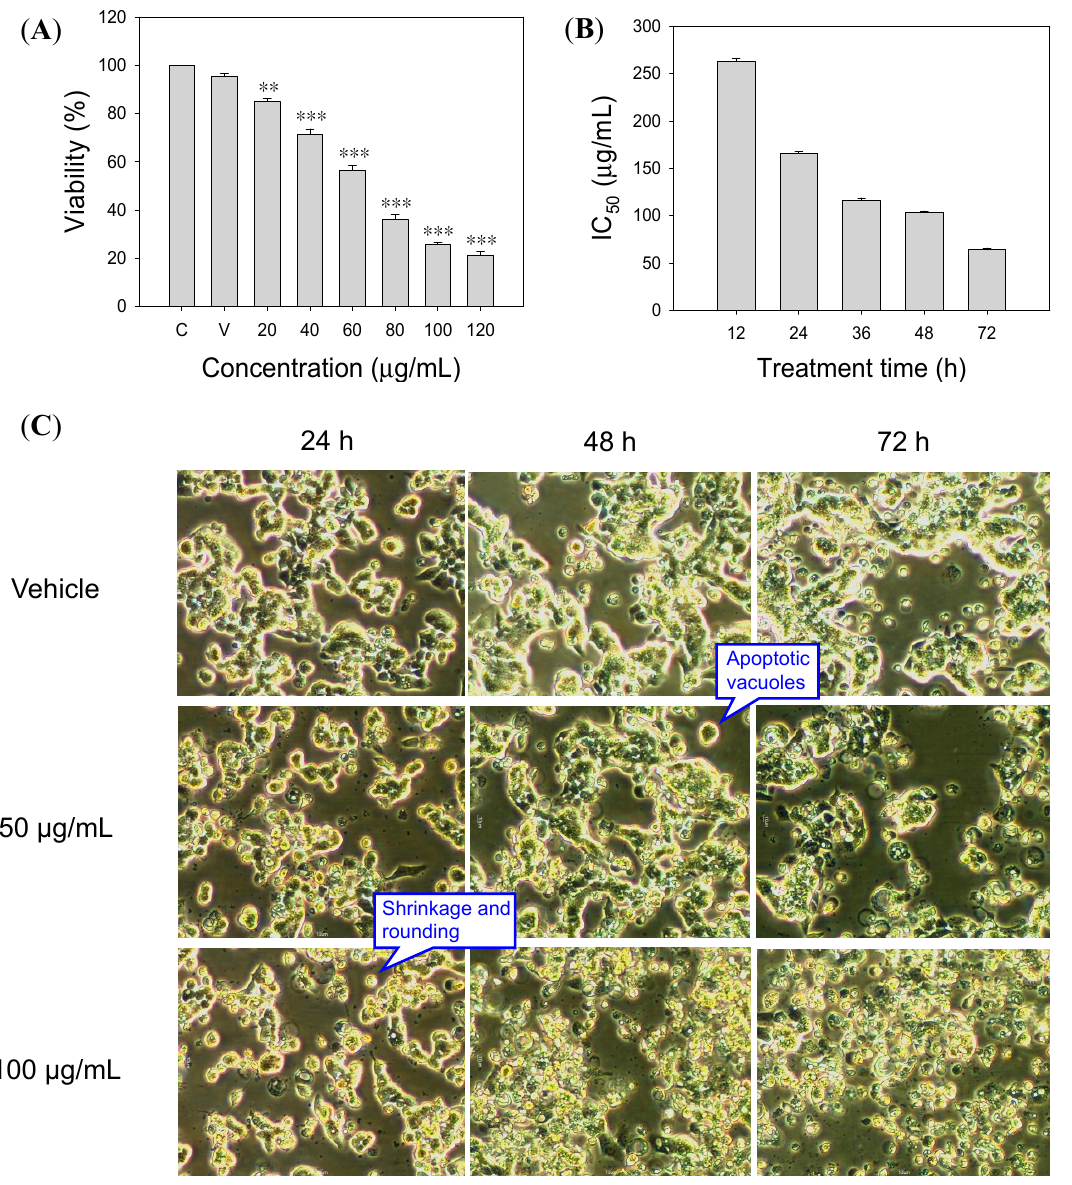
Figure 1. Effects of treatment concentration and duration of SOE on the proliferation of RL95-2 cells. ( A ) Variation in viability under treatment for 72 h with different SOE doses. A significant difference from the Vehicle was indicated as ** p < 0.01, or *** p < 0.001 by Student’s t -test. ( B ) Variation in IC 50 values under different treatment durations. ( C ) Apoptotic morphological changes of RL95-2 endometrial cancer cells by treatment with SOE at different doses and durations. The RL95-2 cells were cultured in 96-well plates at a density of 1 × 10 4 cells/well. Cells were treated with medium only (Control, denotes as “C”), DMSO only (Vehicle, denotes as “V”) or media containing 20–120 μ g/mL SOE for 12–72 h. Photomicrographs, taken directly from culture plates with a phase-contrast microscope (magnification 20×), show apoptotic cells with shrinkage, rounding and